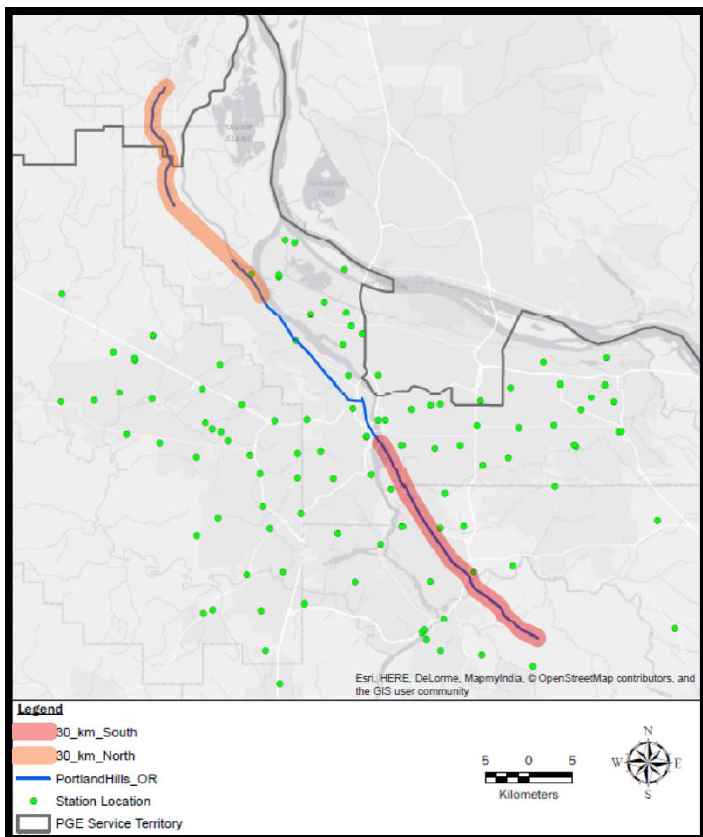
Figure 1. Map of Portland Hills Fault (PHF) location with north, middle and south rupture